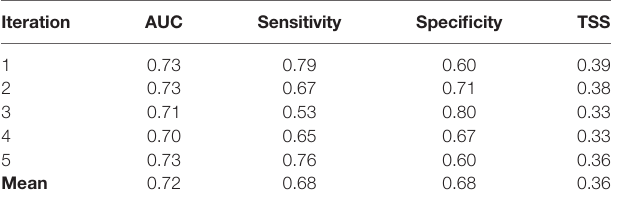
TABLE 4 | Accuracy indices to evaluate the predictive performance of the model: Area Under the receiver operating Curve (AUC), Sensitivity, Speci fi city and True Skill Statistic (TSS).